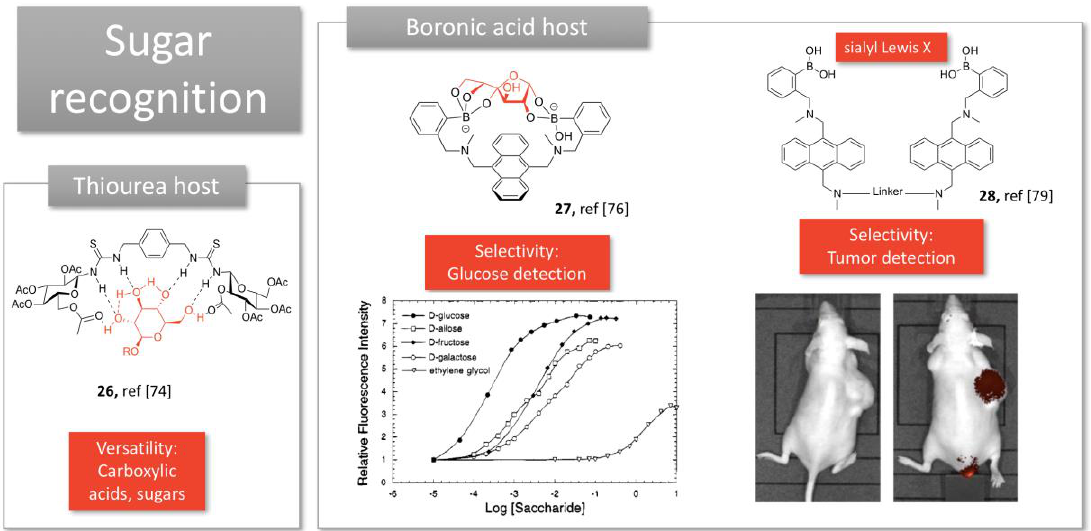
Figure 7. Examples of molecular tweezers used for sugar detection. Adapted from [76,79].